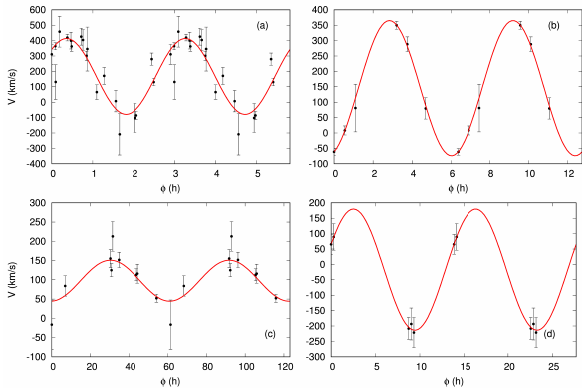
Figure 11. Best orbital solutions for the four objects for which we were able to constrain the period.